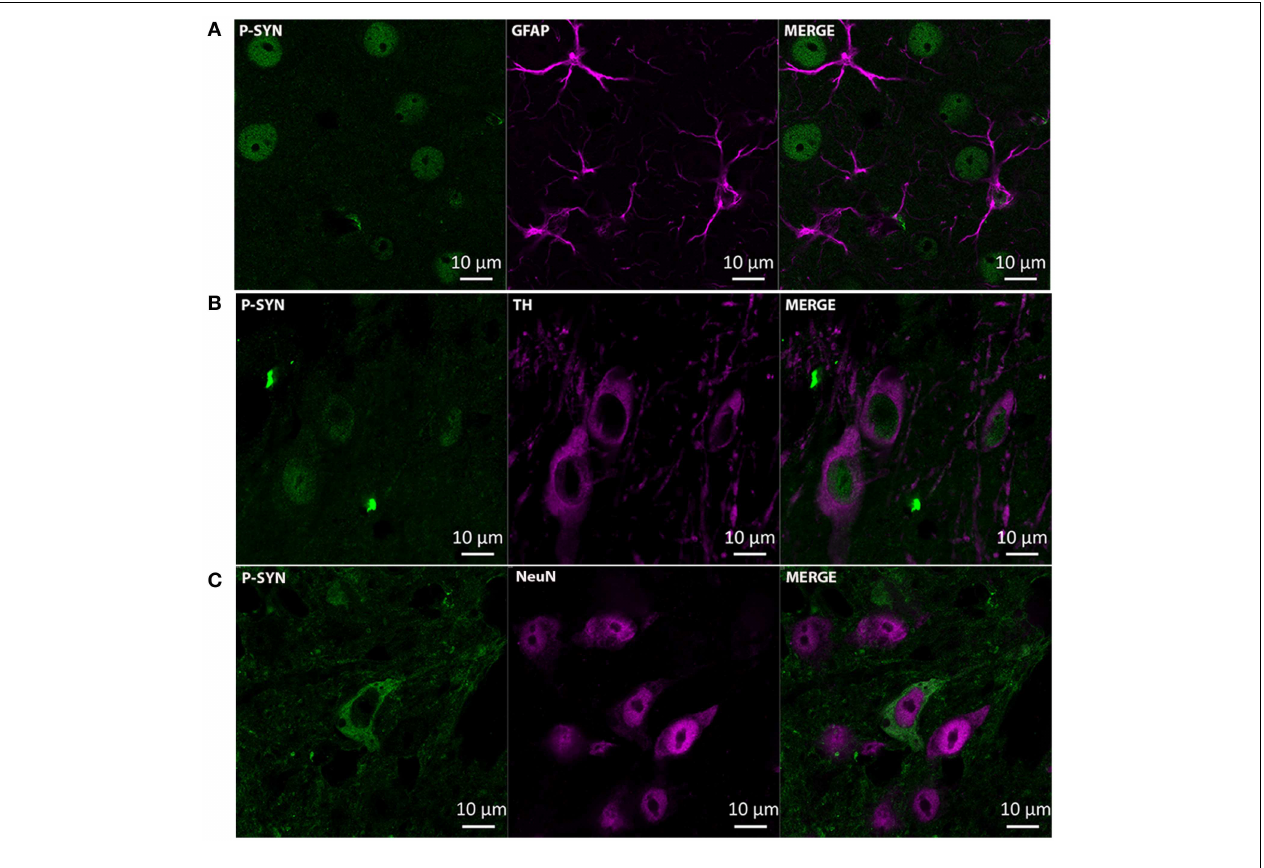
FIGURE 3 | Accumulation of S129-P α -synuclein in SNc neurons of mice receiving 3 µ g LAC. Immunofluorescence analyses demonstrate accumulation of S129-P α -synuclein in nigral TH + (B)